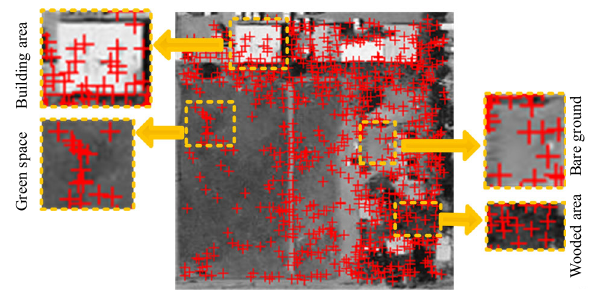
Fig. 2 Generation of initial keypoints in a typical remote sensing